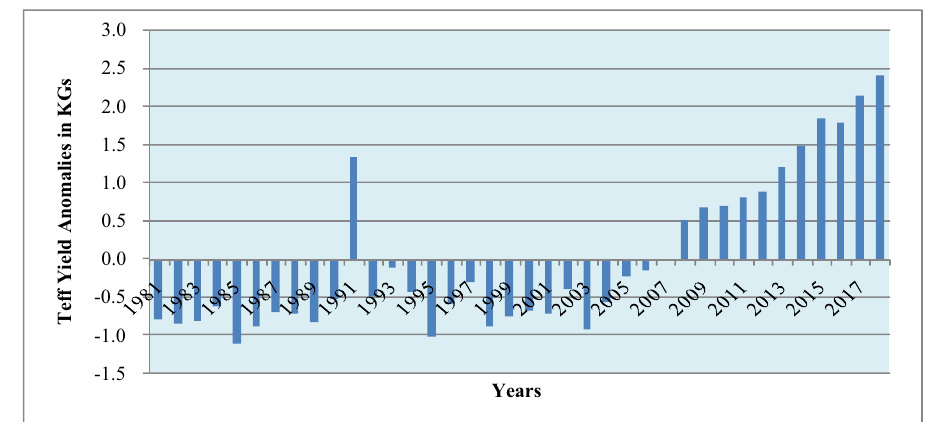
Figuree 10: Year to year yield anomalies of te ff